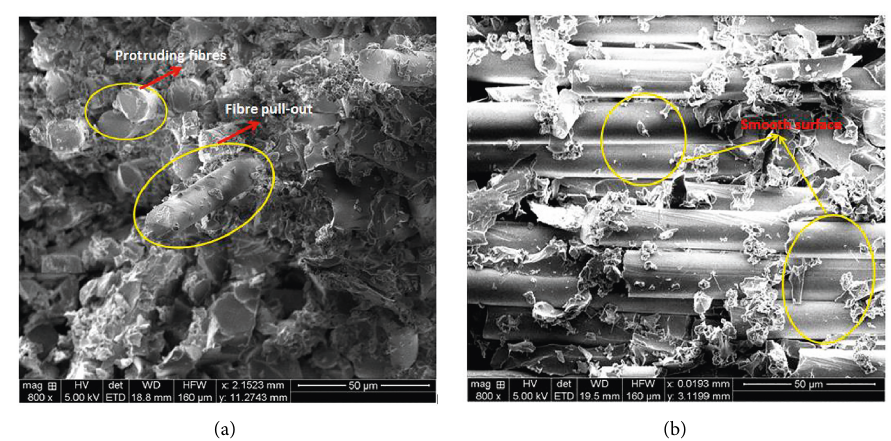
Figure 6: ((a, b) shows the SEM photographs of the inner surface of the drilled